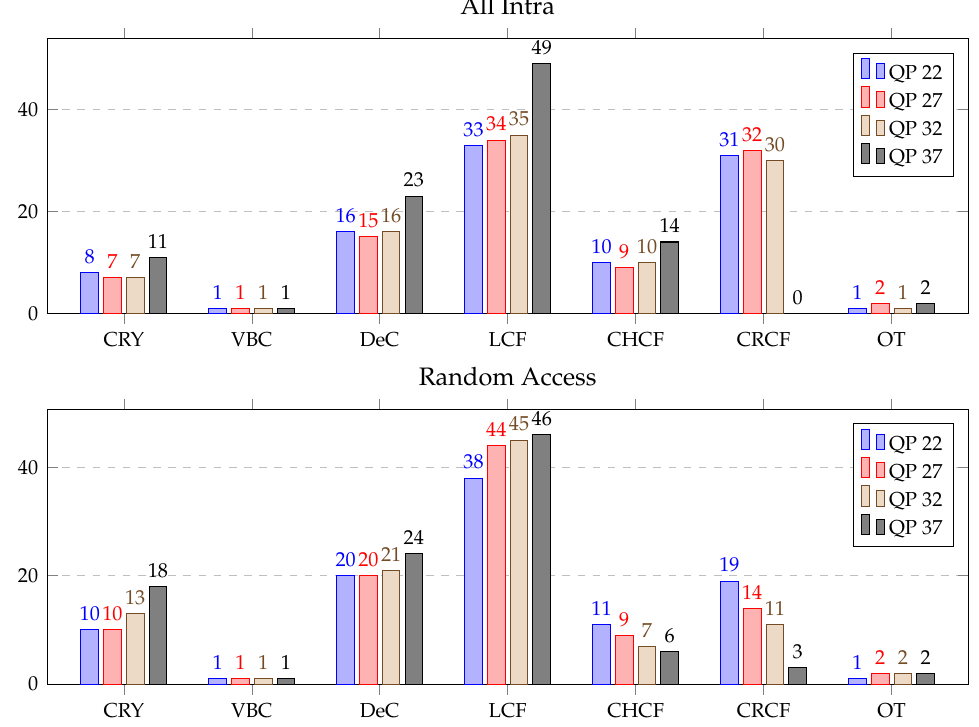
Figure 11. Average time distribution for different parts of the adaptive loop filter (in %) over the HGPP.